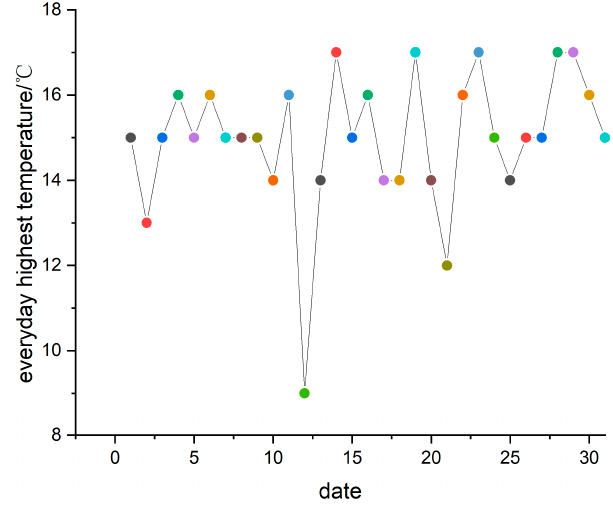
Figure 6. Everyday highest temperature (°C) in August.